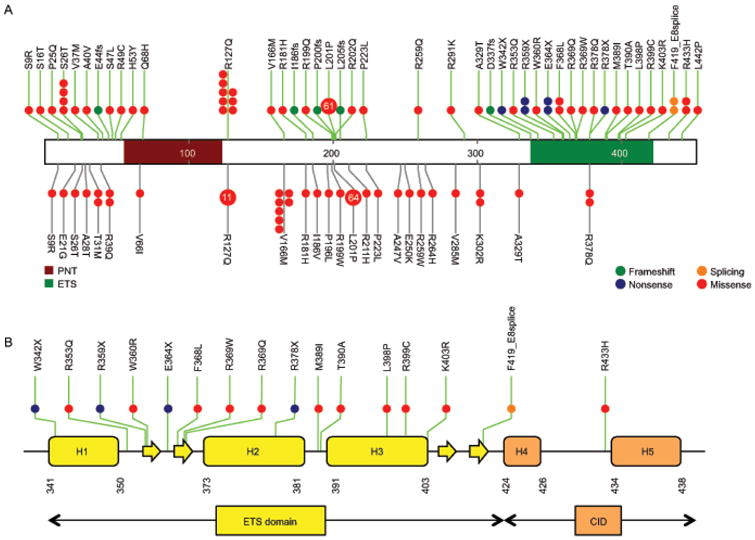
ETV6 variants identified by targeted sequencing in 4,405 unselected ALL cases(A)
ETV6 was sequenced using Illumina HiSeq platform following capture-based enrichment of this genomic region in 4,405 unselected ALL cases. Variants in non-ALL controls were based on publicly available data from the NHLBI Exome Sequencing Project cohort (N=6,503). Exnoic variants are classified as frameshift, nonsense, missense, and splicing (green, blue, red, or orange solid circles, respectively) for ALL cases (green vertical lines) and non-ALL controls (gray vertical lines). Functional domains are indicated by color based on Pfam annotation. Each circle represents a unique individual carrying the indicated variant (heterozygous or homozygous) except variants recurring in more than 10 individuals for which the number in the circle indicates the exact frequency. (B) ALL-related ETV6 variants are highly enriched in the ETS domain which consists of 3 helices (yellow boxes) and 4 β-sheets (yellow arrows). H3 is responsible for direct binding with DNA, which is negatively regulated by the CID domain (H4 and H5, orange boxes) at the C-terminal. Variant function is denoted by the color of each line.